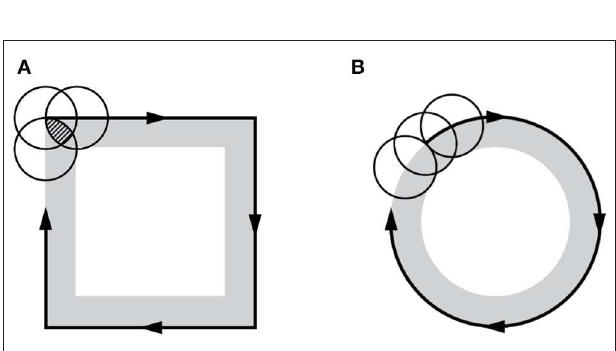
FIGURE 8 | Increment of the overlapped area at the edge of the square, in which the small letters denote the following: (A) overlapped area in square and (B) in